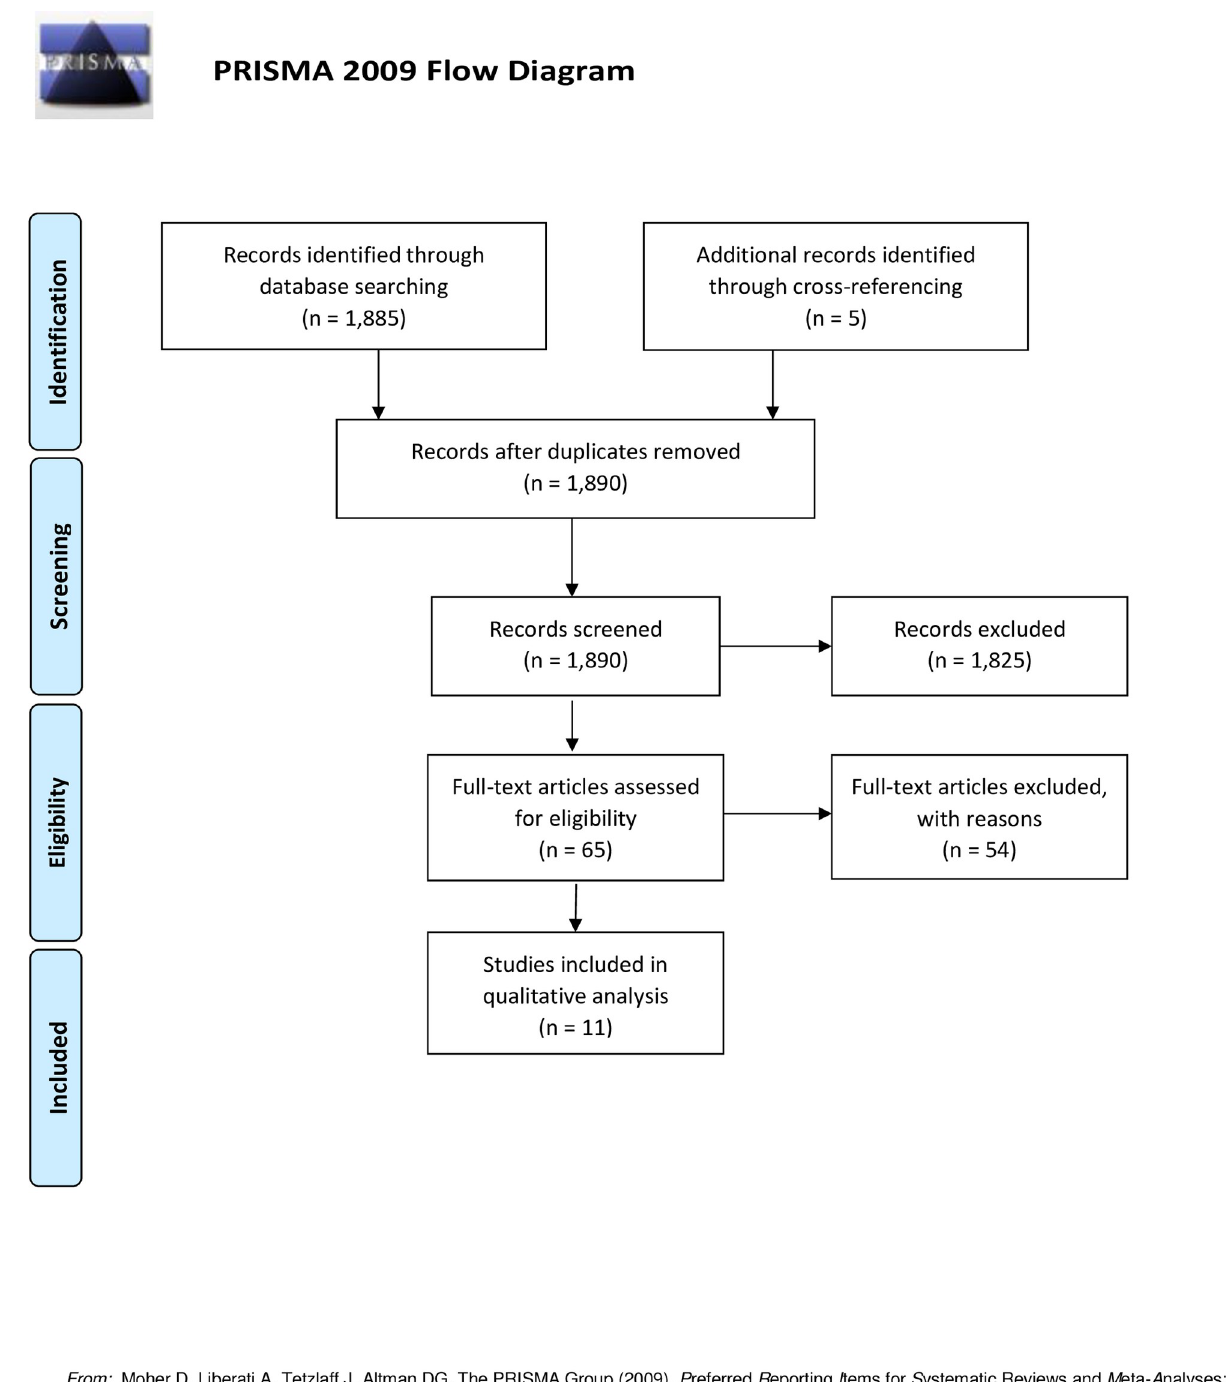
Fig 1. Flow diagram. A total of 1890 articles were obtained through database searching and cross-referencing. After reviewing all 1890 abstracts, only 65 articles met the inclusion criteria and moved onto full-text assessment. Following full-text assessment, only 11 articles met the selection criteria for further qualitative